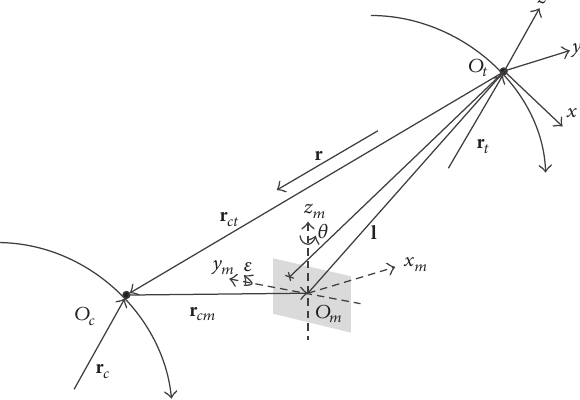
Figure 1: Relative observation